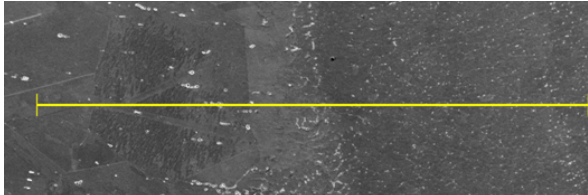
Figure 15: Measure line of HAZ and weld of 316L steel for chemical analyze